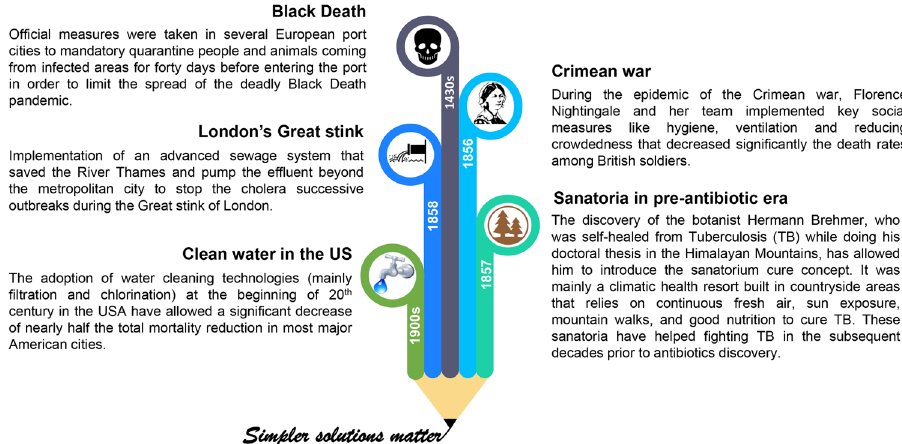
Fig. 1 Some notable public measures outside the medical care realm that have signi fi cantly improved population health. These measures included quarantine during Black Death epidemic 95 , hygiene and social distancing in the Crimean war 62 , the building of mountain sanatoria to cure TB 96 – 98 , the implementation of a sewage system to overcome London ’ s Great stink 63,64 , and the introduction of water fi ltration and chlorination systems/technologies to clean potable water in the USA 99